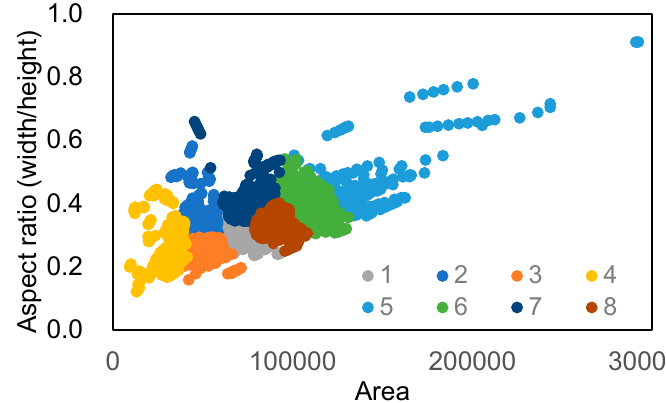
Figure 8. Clustering result of bounding boxes included in the training dataset. Each plot in this figure corresponds to each bounding box. Each plot was clustered using the K-medoids algorithm based on the distance defined in Equation (4).